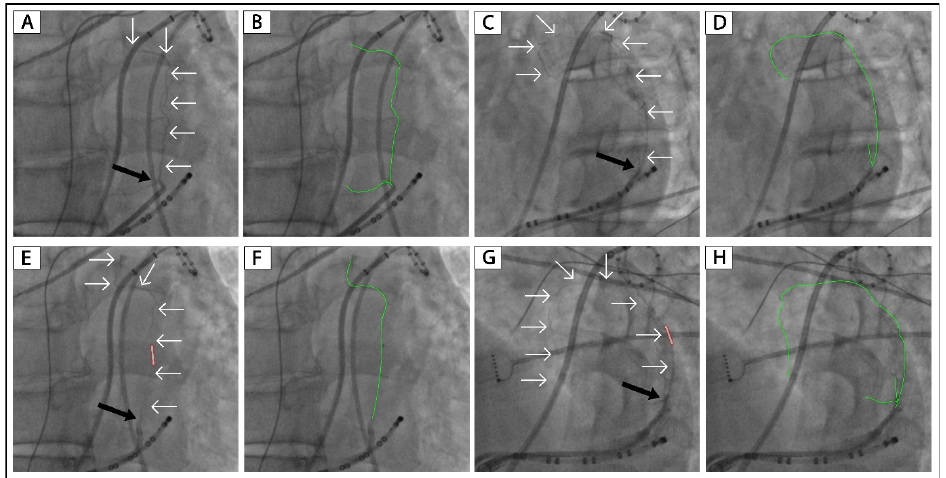
Figure 1. VOM collateralization in a patient without ethanol infusion attempt. ( A , C ): Non-occluded venograms of VOM in the RAO and LAO projection, respectively. ( E , G ): Balloon occluded venograms of VOM in the RAO and LAO projection, respectively. ( B , D , F , H ): Highlighted VOMs of panels ( A , C , E , G ), respectively. The black arrow indicates the ostium of VOM. The white arrows and green lines indicate the drainage of the VOM. The tubule outlined in red indicates the angioplasty balloon. VOM, the vein of Marshall; RAO, right anterior oblique; LAO, left anterior